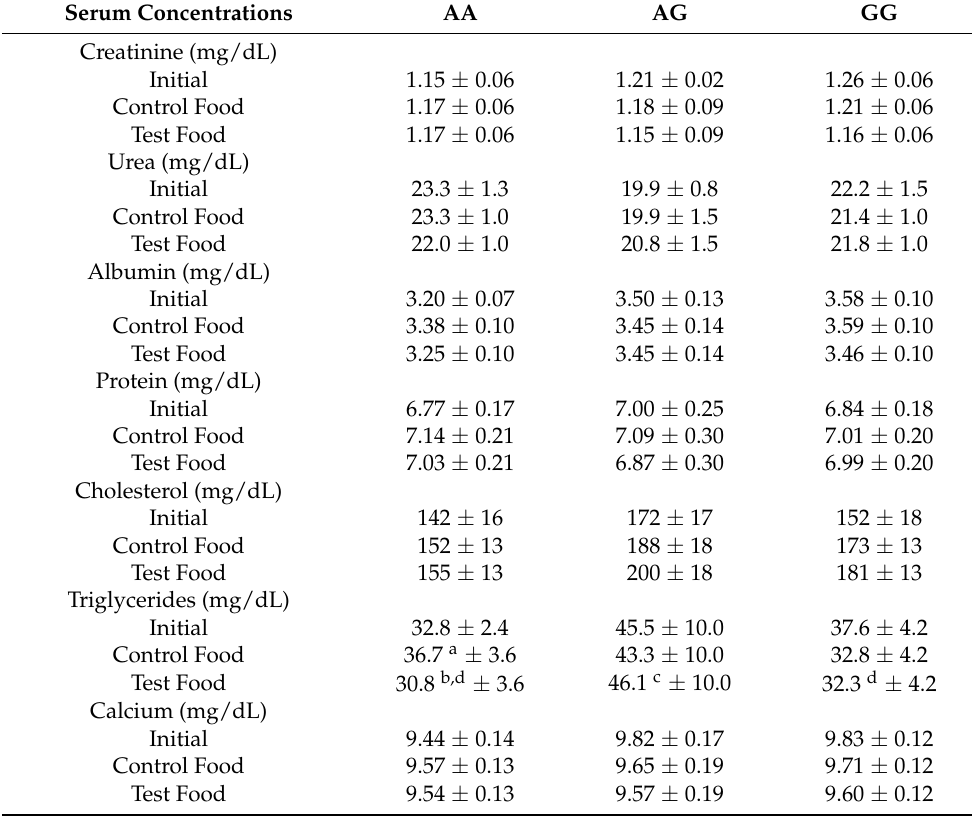
Table 4. Concentrations (mean ± SEM) of selected serum parameters in cats with different alanine- glyoxylate aminotransferase 2 (AGXT2) single nucleotide polymorphisms (SNPs), at the end of the 28-day pre-feeding period (Initial) and after consuming control or test food for 28 days. Serum